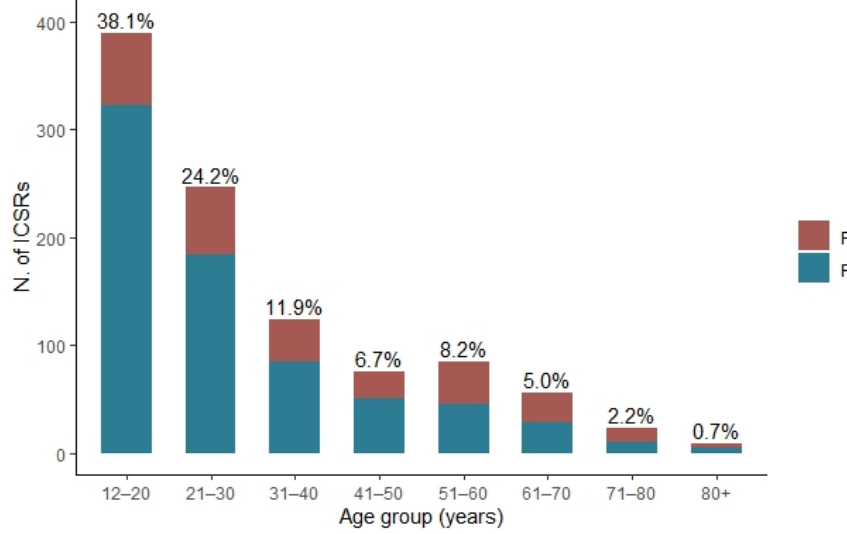
Figure 5. Distribution of cases of myocarditis and pericarditis following the first and second dose of mRNA COVID-19 vaccines with stratification by age group.